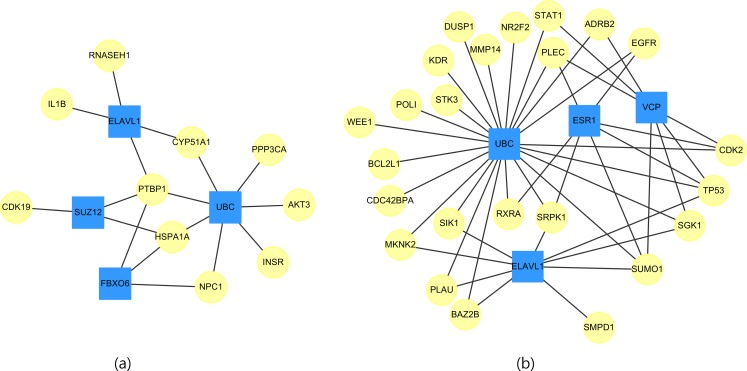
The top four genes (squares) which connect to the largest, the second largest, the third largest and the fourth largest degree of targeted genes (circles) for (A) up-regulated and (B) down-regulated CVDs network.